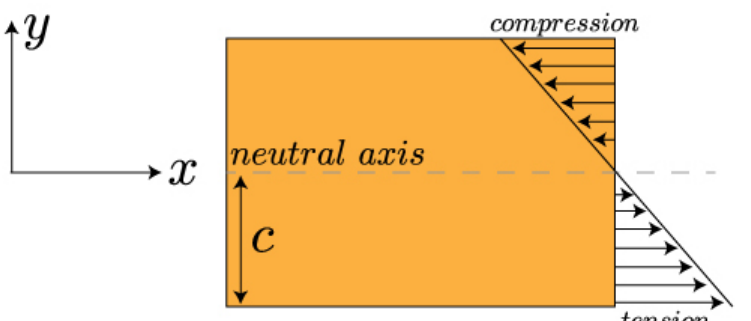
Figure 3. Stress distribution on the beam during bending.